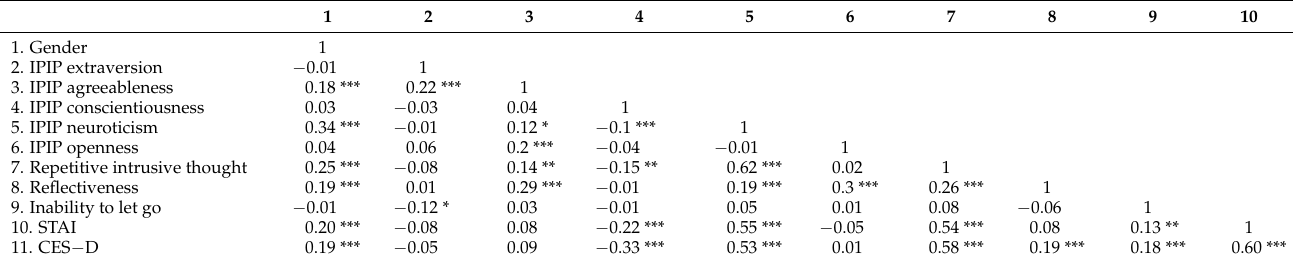
Table 2. Correlations between variables of interest for the regression analyses in Sample